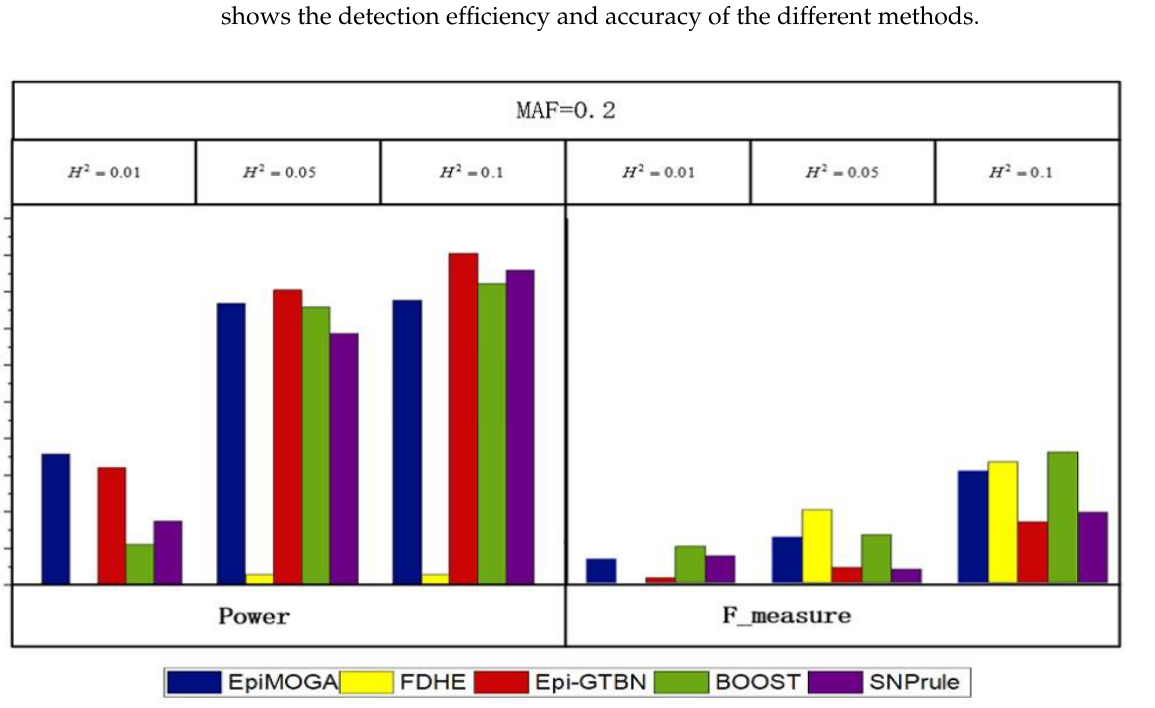
Table 2. Two index values of EpiMOGA, FDHE-IW, BOOST and Epi-GTBN (MAF = 0.2, sample size = 600).